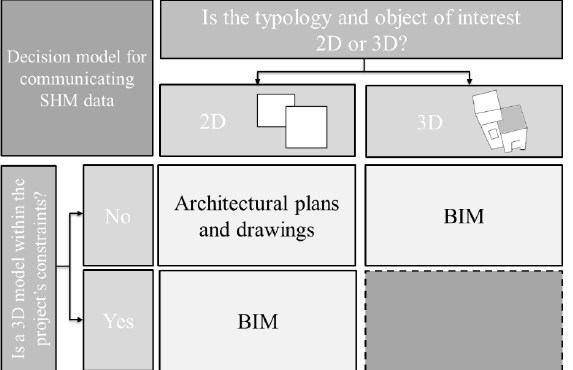
Figure 1. Decision model for documenting and communicating SHM data and metadata (Building images adapted from [26].